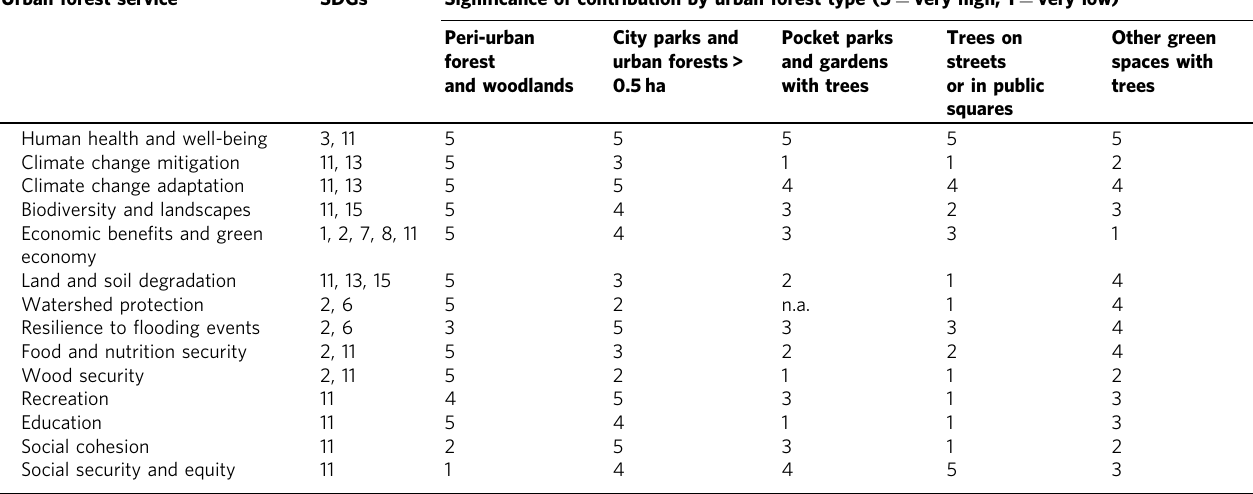
Table 1 Services from fi ve urban forest types advance UN Sustainable Development Goals with varying signi fi cance Urban forest